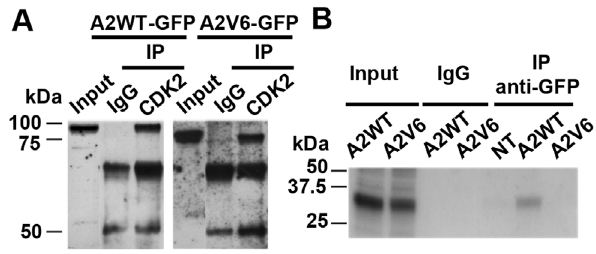
Figure 4. A2V6-GFP binds CDK2 without inducing H1 kinase activity. ( A ) Anti-GFP immunoblot (IB) from cell lysates immunopre- cipitated (IP) with anti-CDK2 antibody. The A2V6-GFP fusion protein ( < 75 kDa) interacts with CDK2 like the A2WT-GFP fusion protein ( < 85 kDa). IgG: non-specific antibody control. ( B ) Autoradiography of 32 P-labeled histone H1 performed after anti-GFP immunoprecipitation in lysates from A2WT- and A2V6-GFP transfected cells. IgG: non-specific antibody control. Input: non-immunoprecipitated lysate. No phosphor- ylated histone H1 was detected in A2V6-GFP transfected cells, indicating that the A2V6/CDK2 complexes, contrary to the A2WT/ CDK2 ones, are not functional. The phosphorylated histone H1 in the input lanes corresponds to the global kinase activity of cycling asynchronous cells.